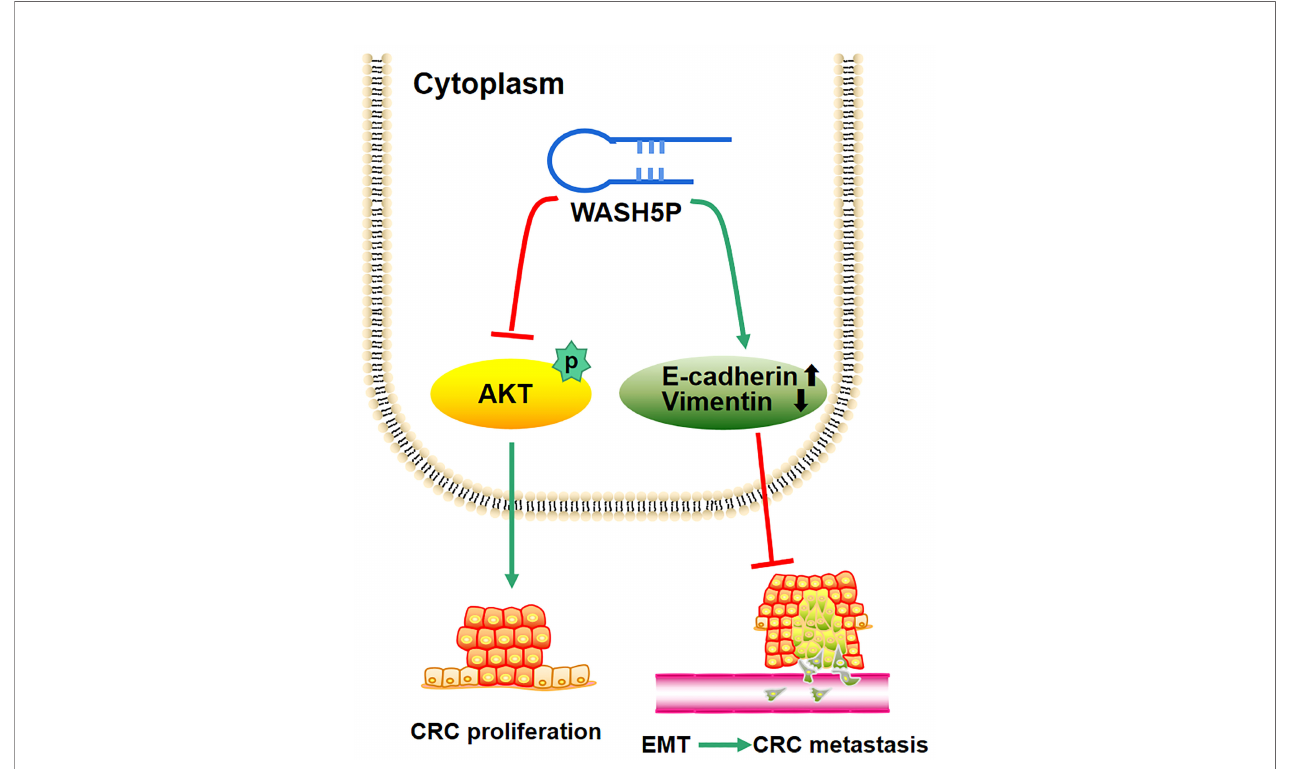
FIGURE 5 | Schematic model of the role of lncRNA WASH5P in colorectal cancer. lncRNA WASH5P could inhibit CRC via repressing the AKT signaling pathway and